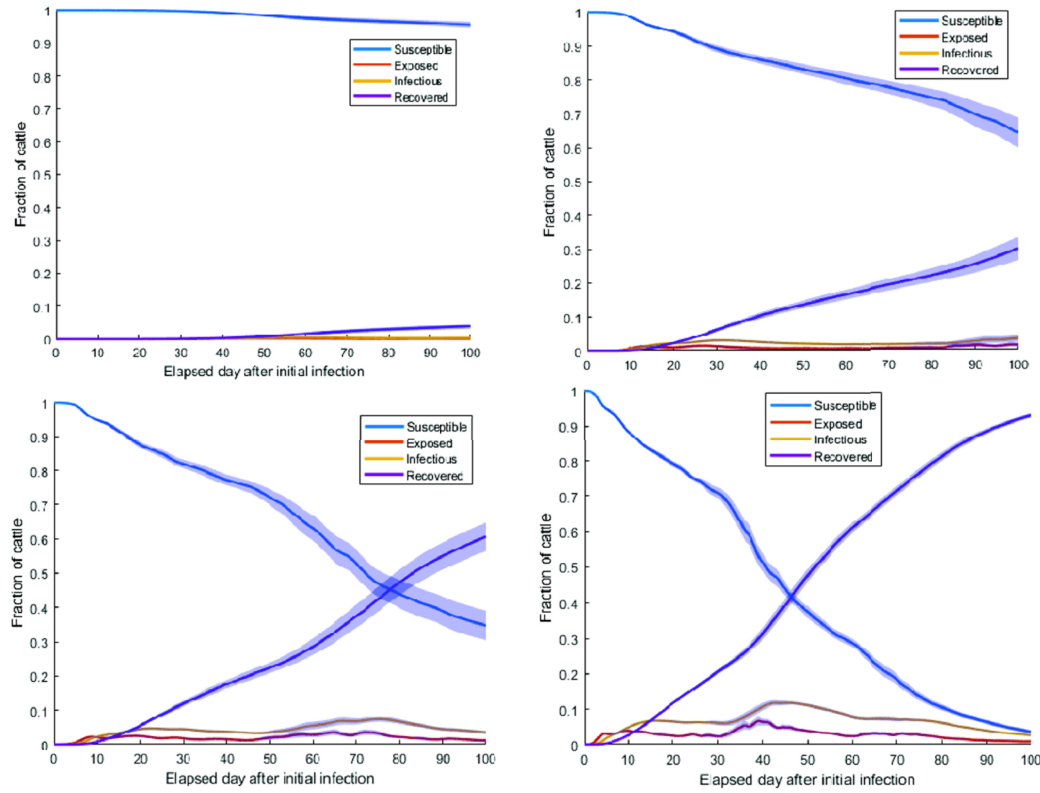
Fig 11. Fraction of cows in each compartment with a 95 percent confidence interval for β = 0.001 (top left), 0.005 (top right), 0.01 (bottom left), and 0.03 (bottom right) and for heterogeneous network; increasing β showed an increasing trend in the overall fractions of recovered (cumulative fractions of infected) which reaches to almost 1 for β = 0.03.